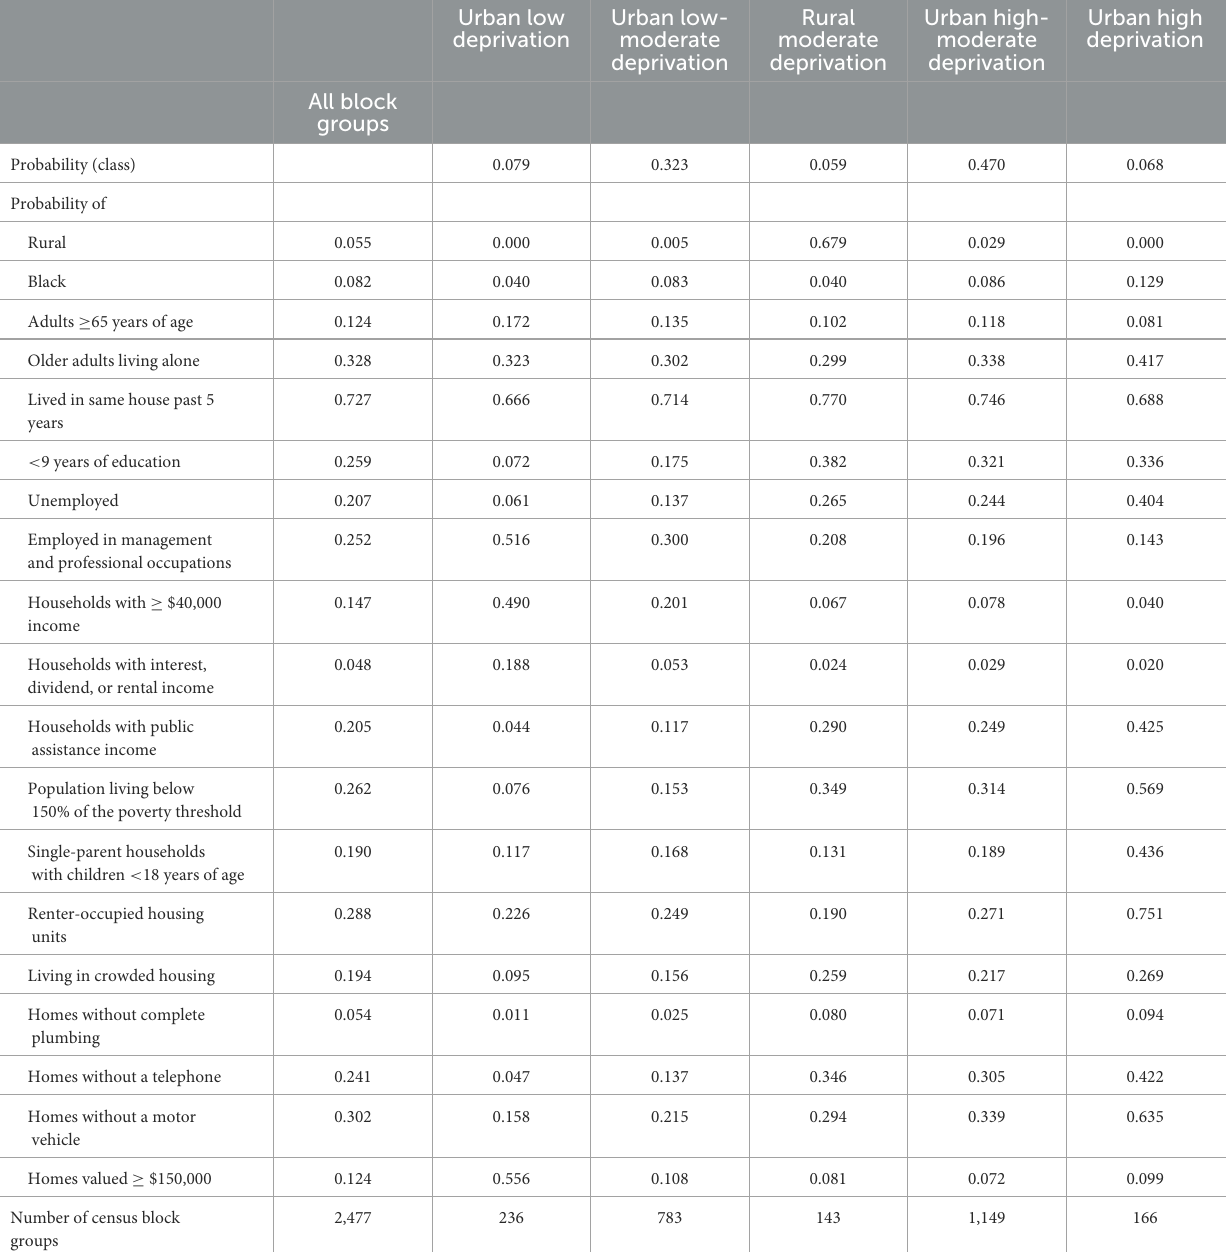
TABLE 1 Summary of latent classes based on the year 2000 census block groups in Puerto Rico.